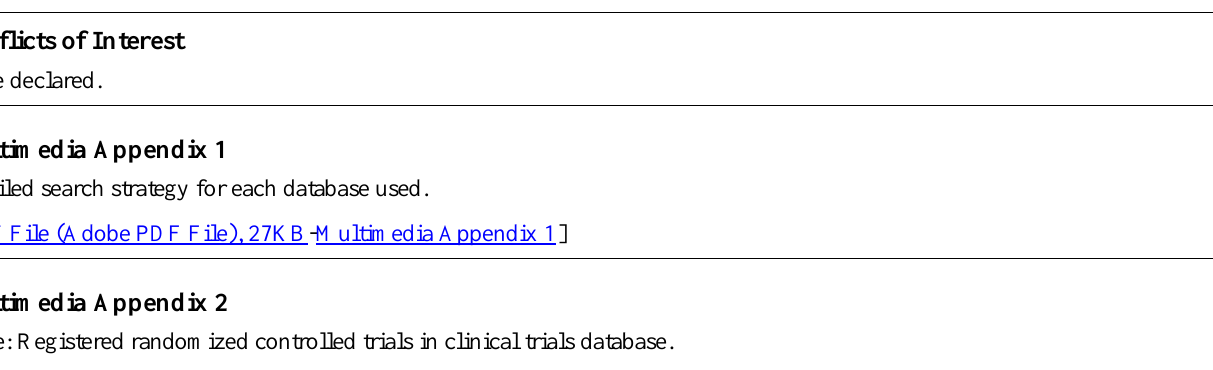
Table: Registered randomized controlled trials in clinical trials